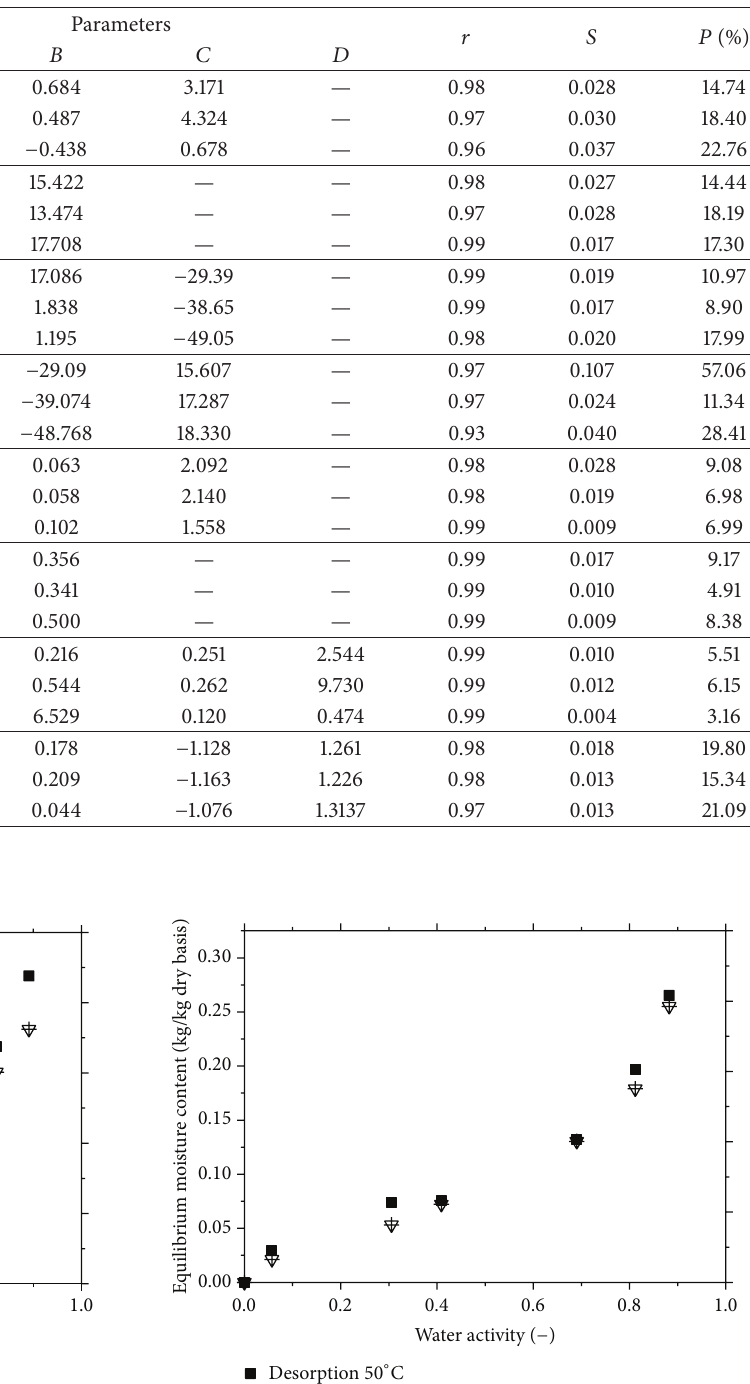
Table 3: Results of fitting of the desorption isotherms of Ziziphus spina-christi leaves.